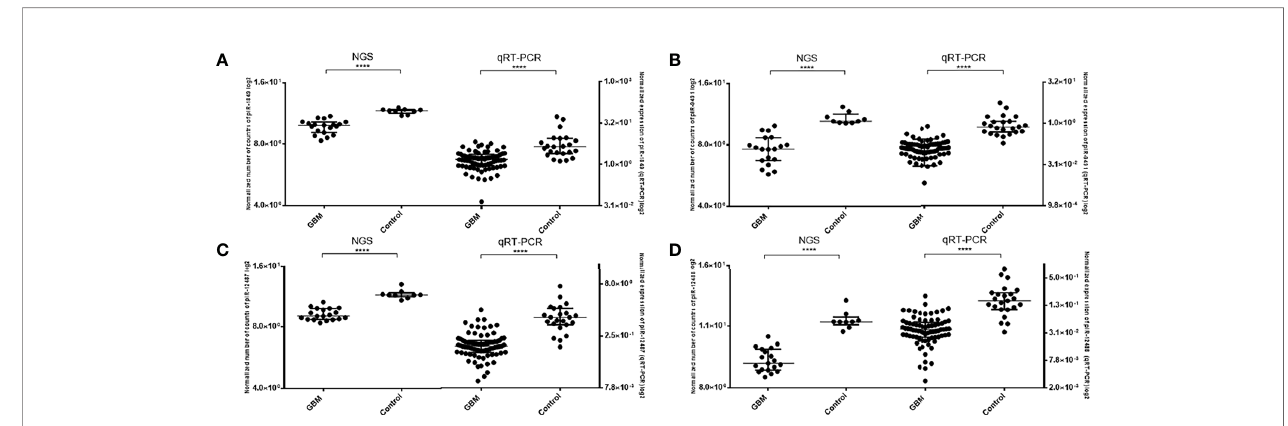
FIGURE 2 | Results of Mann – Whitney analysis of independent validation of selected piRNAs and comparison between obtained results from next-generation sequencing and qRT-PCR. (A) piR-1849; (B) piR-9491; (C) piR-12487; (D) piR-12488. **** p <